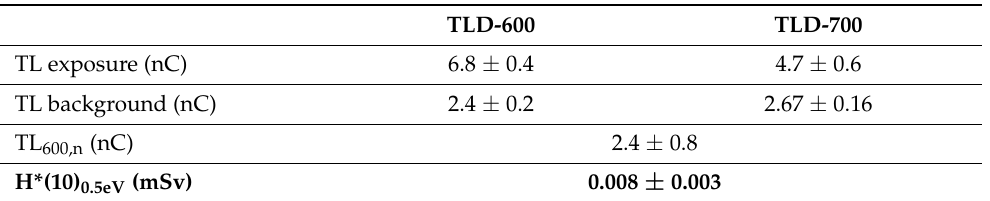
Table 2. Measured signal of thermoluminescent dosimeters (TLD-600 and TLD-700) and neutron thermal dose equivalent (H*(10) 0.5eV